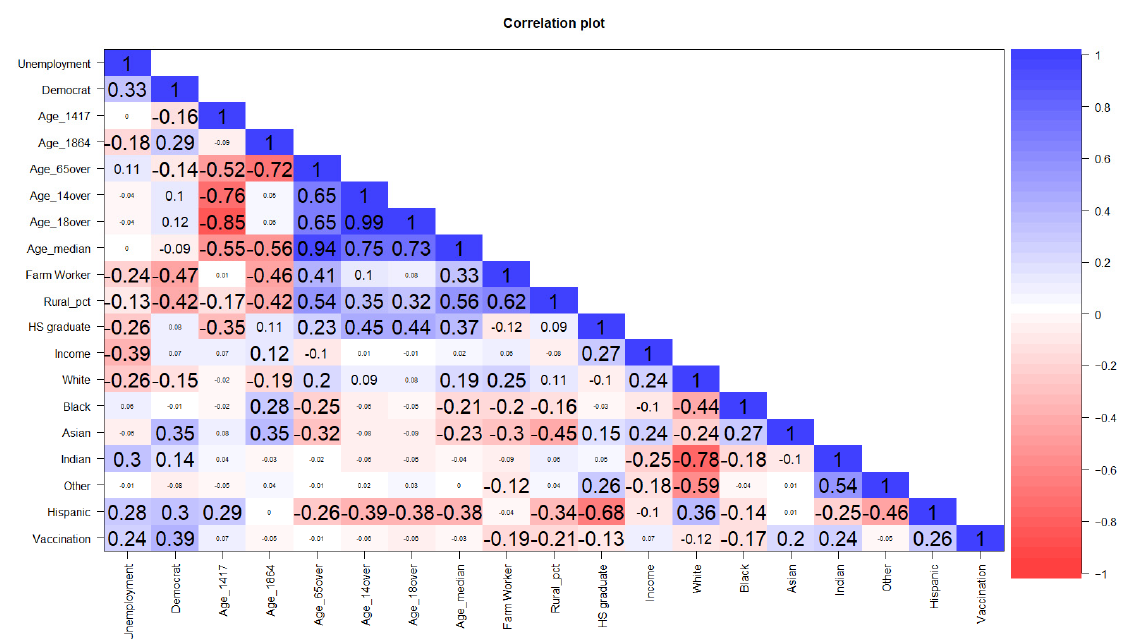
Figure 3. Pairwise correlations among socioeconomic variables. All significant correlations are ex- pressed in bold. in